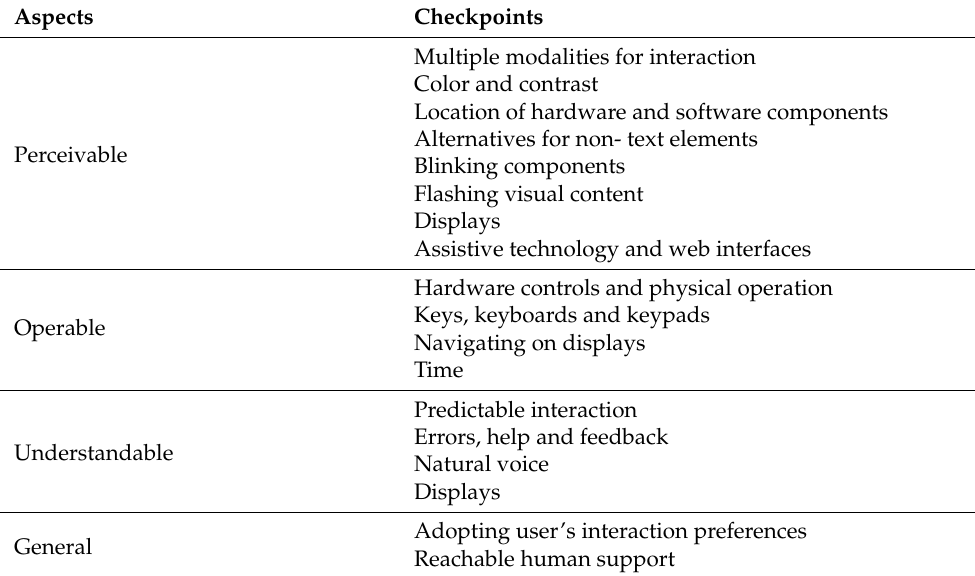
Table 1. General classification of the proposed guidelines